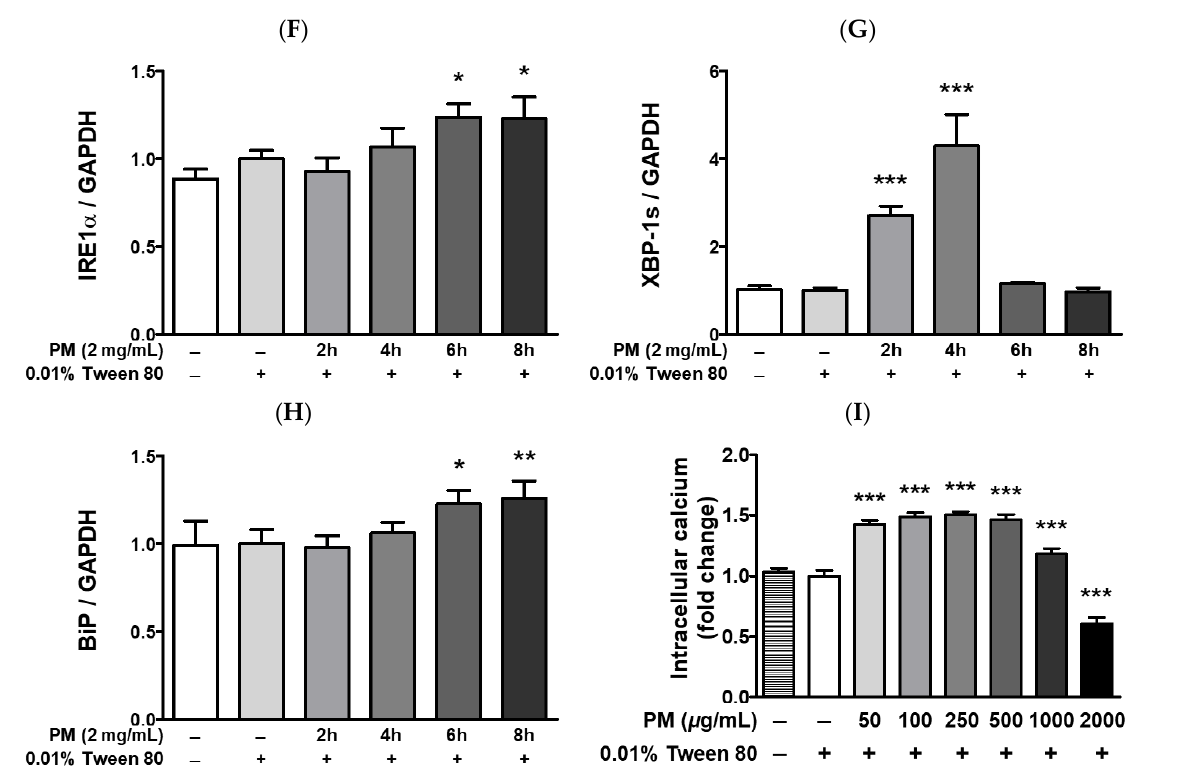
Figure 7. UPR-related protein expression and intracellular calcium levels [Ca 2+ ] i in PM-treated ARPE-19 cells. Cells were treated with 2 mg/mL of PM for 0–8 h and ( A ) UPR-related protein expression levels were assessed by western blot, using 0.01% Tween-80 as a vehicle control and GAPDH as the assay loading control and for normalization. The protein expressions of ( B ) PERK, ( C ) p-eIF2 α /t-eIF2 α , ( D ) ATF, ( E ) CHOP, ( F ) IRE1 α , ( G ) XBP-1s, and ( H ) BiP are shown. ( I ) Cytosolic [Ca 2+ ] i level was measured by fluorescence. Data are portrayed as mean ± SD ( n = 3). For calcium measurement; n = 5. Data were analyzed using one-way ANOVA followed by Tukey’s multiple comparison (* p < 0.05, ** p < 0.01, *** p < 0.001). All comparisons were made against the vehicle control group. Abbreviations used in Figure: PM; particulate matter, PERK; protein kinase R-like endoplasmic reticulum kinase, eIF2α; eukaryotic translation initiation factor 2 alpha, ATF4; activating transcription factor 4, CHOP; CCAAT/enhancer-binding protein homologous protein, IRE1α; inositol-requiring enzyme 1 alpha, XBP-1s; spliced X-box binding protein 1, BiP; binding of immunoglobulin protein, GAPDH; glyceraldehyde-3-phosphate dehydrogenase, p; phosphorylated, t; total.